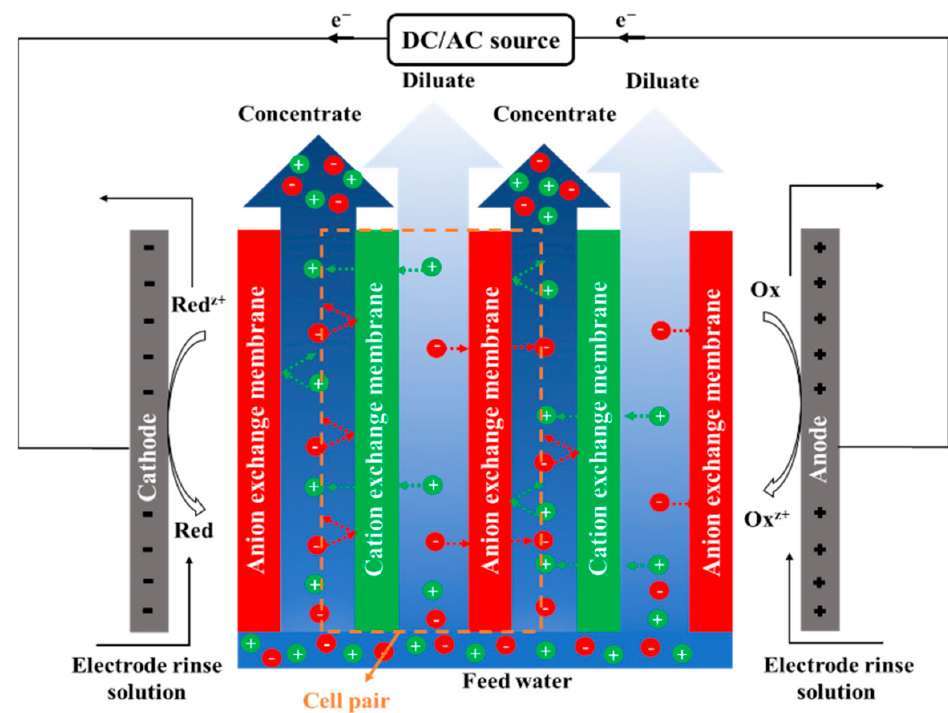
Figure 9. A schematic diagram of an electrodialysis (ED) stack [122] . Electrodeionization Electrodeionization (EDI)